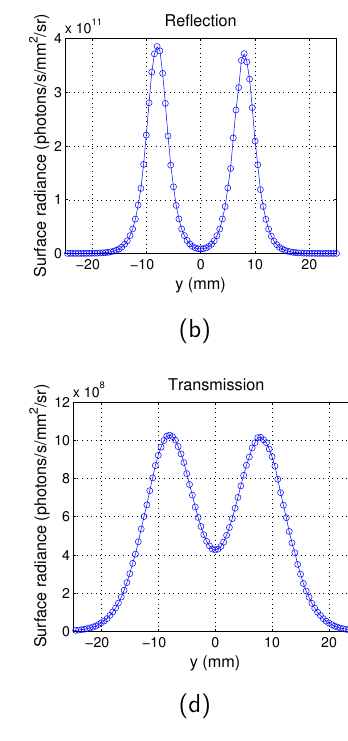
Figure 3. Surface radiance for full-field illumination imaging system. z = − 4mm. Separation between the two targets is D = 16mm. λ ex = 600nm. λ em = 620nm. ( a ) Map for reflection mode; ( b ) surface radiance along y direction at x = 0mm for reflection mode; ( c ) map for transmission mode; and ( d ) surface radiance along y direction at x = 0mm for transmission